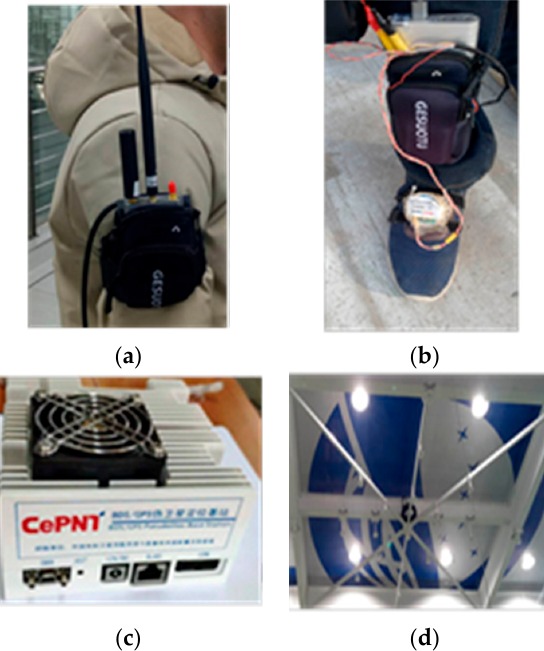
Figure 8. The experiment route of the pedestrian walking. ( a ) The indoor part of the pedestrian walking, ( b ) indoor room and indoor corridors, and the pedestrian walked along yellow-black cross strips.